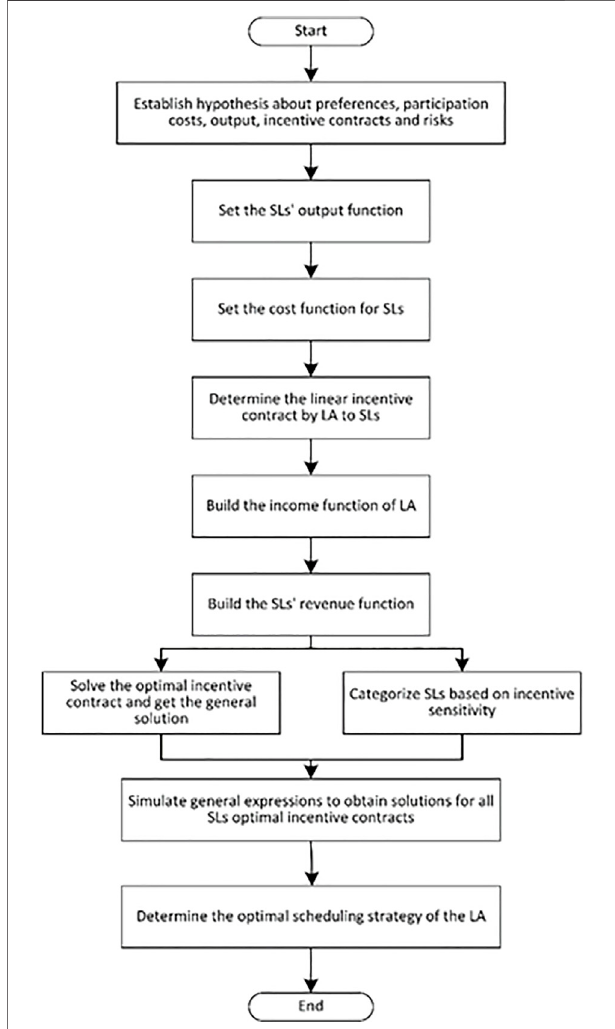
FIGURE 1 | Flow chart of the LA incentive model based on SLs ’